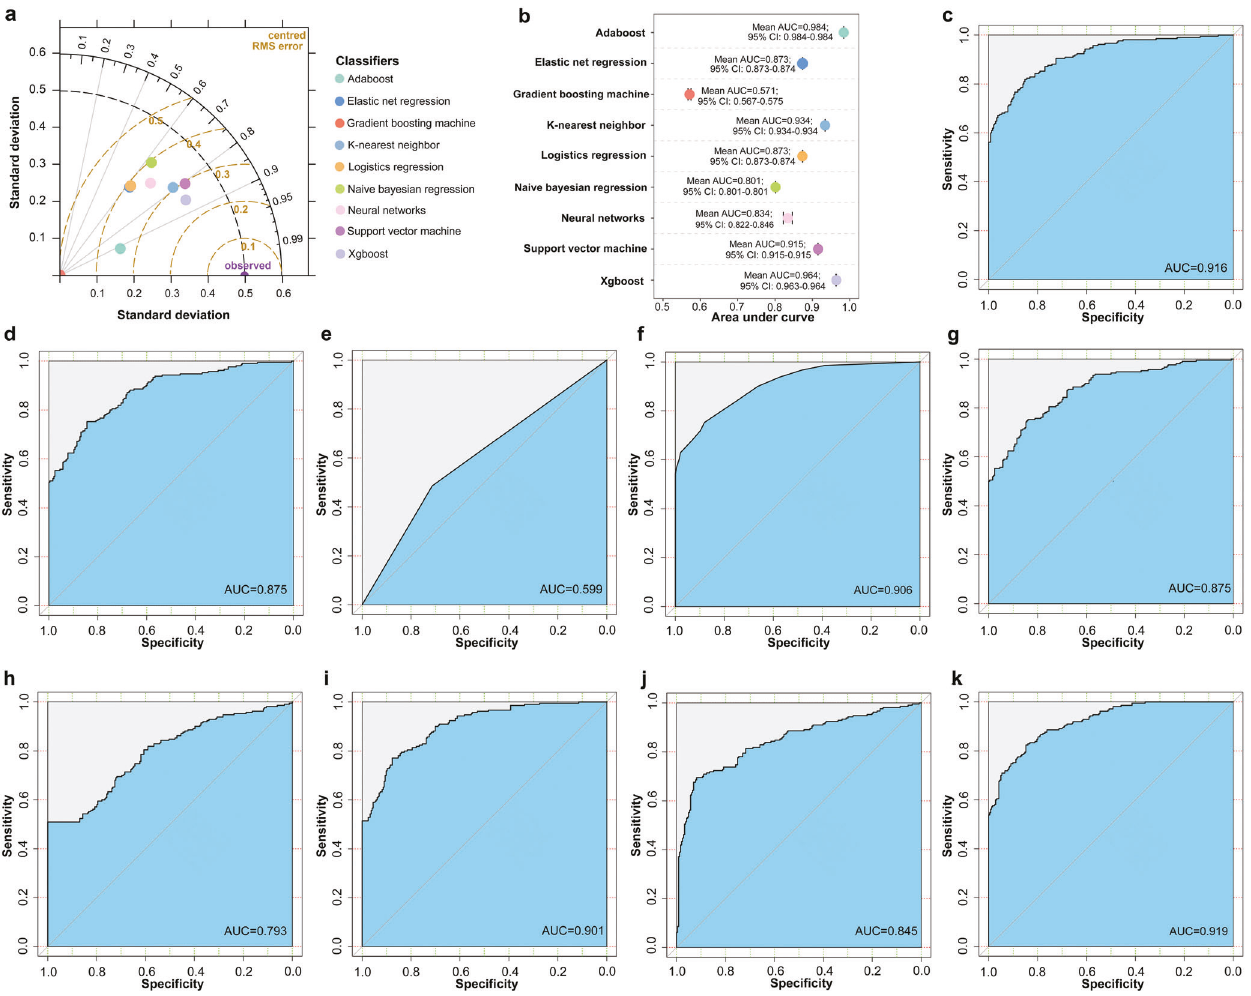
Fig. 4 The performance of different classi fi ers. a Taylor diagram assessing the quality of classi fi er predictions against the reference in the training set. b Forest plot showing the results of bootstrapping. c – k Receiver operating characteristic curves of different classi fi ers (adaboost, elastic net regression, gradient boosting machine, K-nearest neighbor, logistics regression, naive bayesian regression, neural networks, support vector machine and xgboost, respectively) in the test set. Adaboost adaptive boosting, xgboost eXtreme gradient boosting, AUC area under curve, CI con fi dence